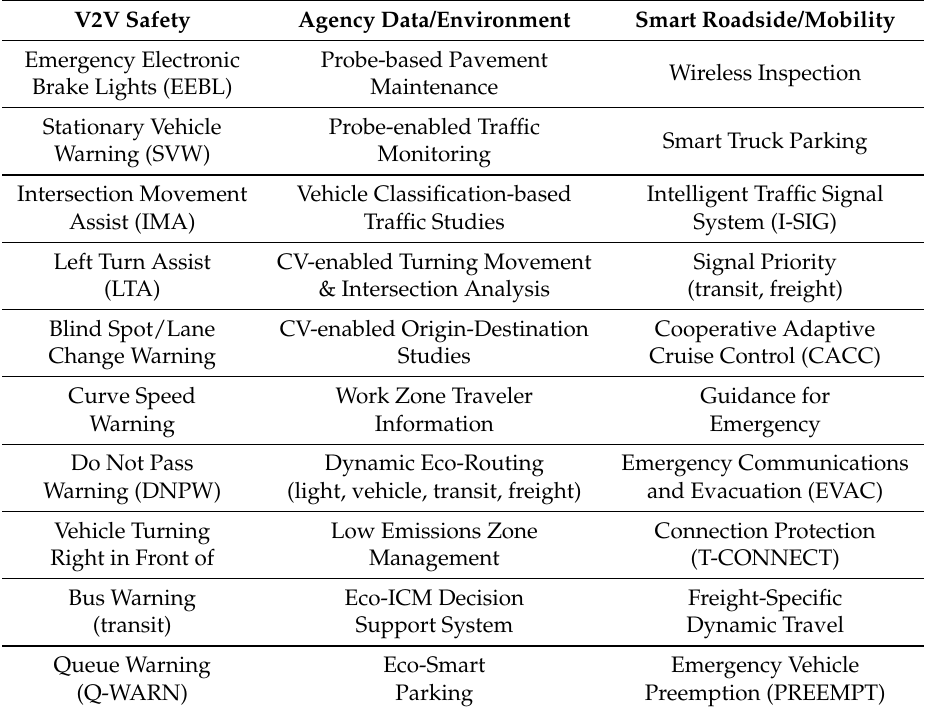
Figure 3. Possible architectural configuration of a 5G-enabled vehicle-to-vehicle (V2V) communication. Table 1. Fascinating potential applications for 5G-connected